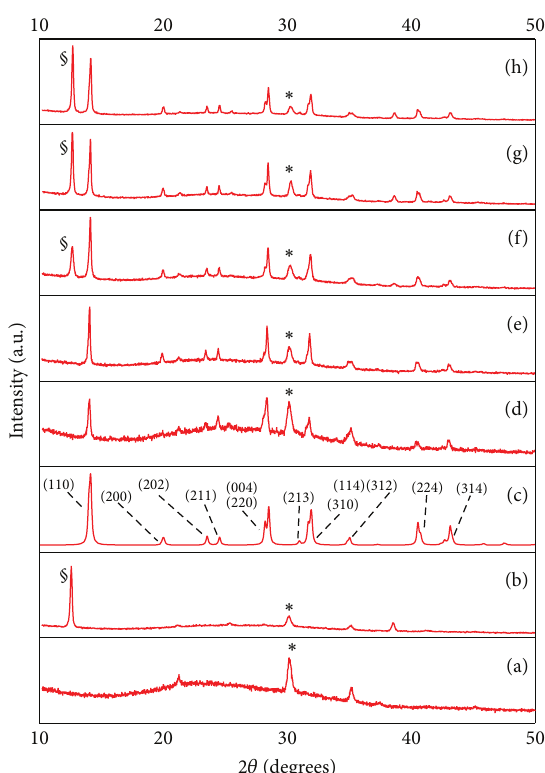
Figure 10: PXRD of (a) bare ITO/ZnO, (b) PbI 2 , (c) calculated tetragonal CH 3 NH 3 PbI 3 , (d) 61 nm thick CH 3 NH 3 PbI 3 , (e) 200 nm CH 3 NH 3 PbI 3 , (f) 280 nm CH 3 NH 3 PbI 3 , (g) 400 nm CH 3 NH 3 PbI 3 , and (h) 560 nm CH 3 NH 3 PbI 3 . § refers to a peak that is indicative of crystalline PbI 2 and ∗ is indicative of ITO glass substrate. As the perovskite layer thickness increases, the unreacted crystalline PbI 2 also increases. Reproduced from [23] with permission from the Royal Society of